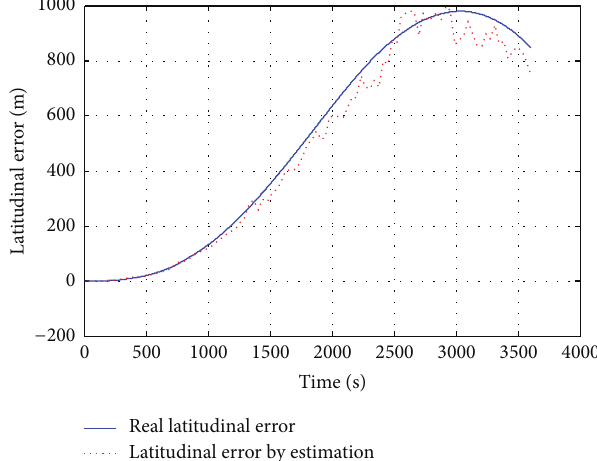
Figure 6: Latitudinal error of a strapdown system with known error